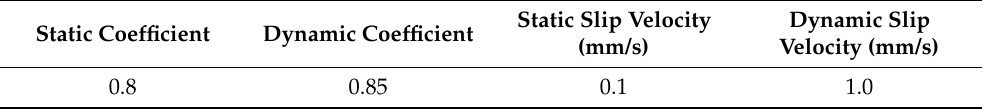
Table 5. Friction coefficients of the spherical waste and the sorting system.